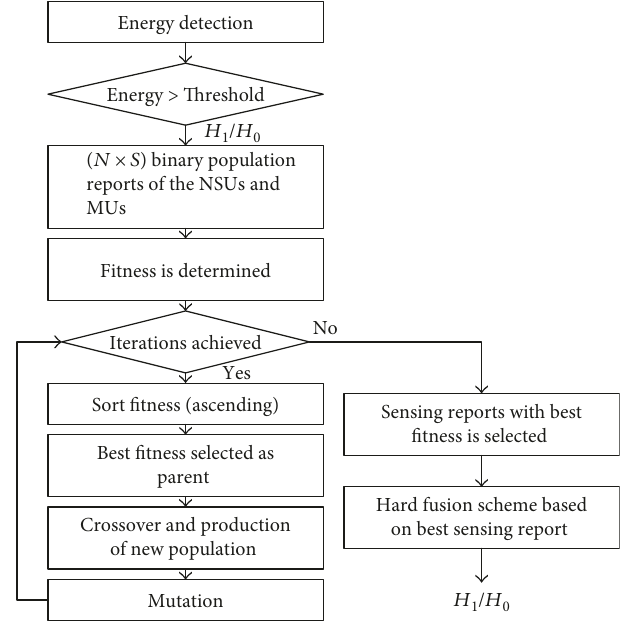
Figure 3: Proposed CSS fl